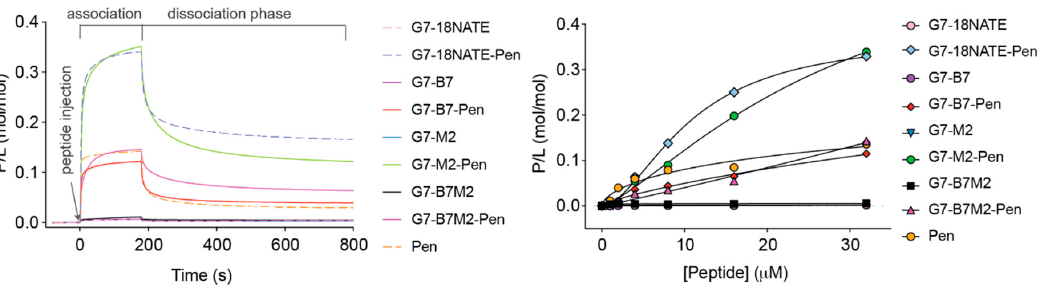
Figure 8. Binding of G7-peptides with model membranes as studied using surface plasmon resonance. Lipid bilayers composed of POPC/POPS (4:1 molar ratio) were deposited onto an L1 chip and peptide samples were injected for 180 s (association phase) and their dissociation followed for 600 s (dissociation phase). Response units (RU) signal obtained from surface plasmon resonance (SPR) were converted into moles of peptide and normalized to the lipid deposited onto the chip surface (1 RU = 1 pg/mm 2 ) to obtained peptide-to-lipid-ratios (P/L). Left panel shows sensorgrams obtained upon injection of 32 μ M peptide samples. Right panel shows dose-response curves in which the P/L obtained at the end of association phase (t = 170 s) is plotted as a function of peptide sample concentration injected over the lipid bilayer.